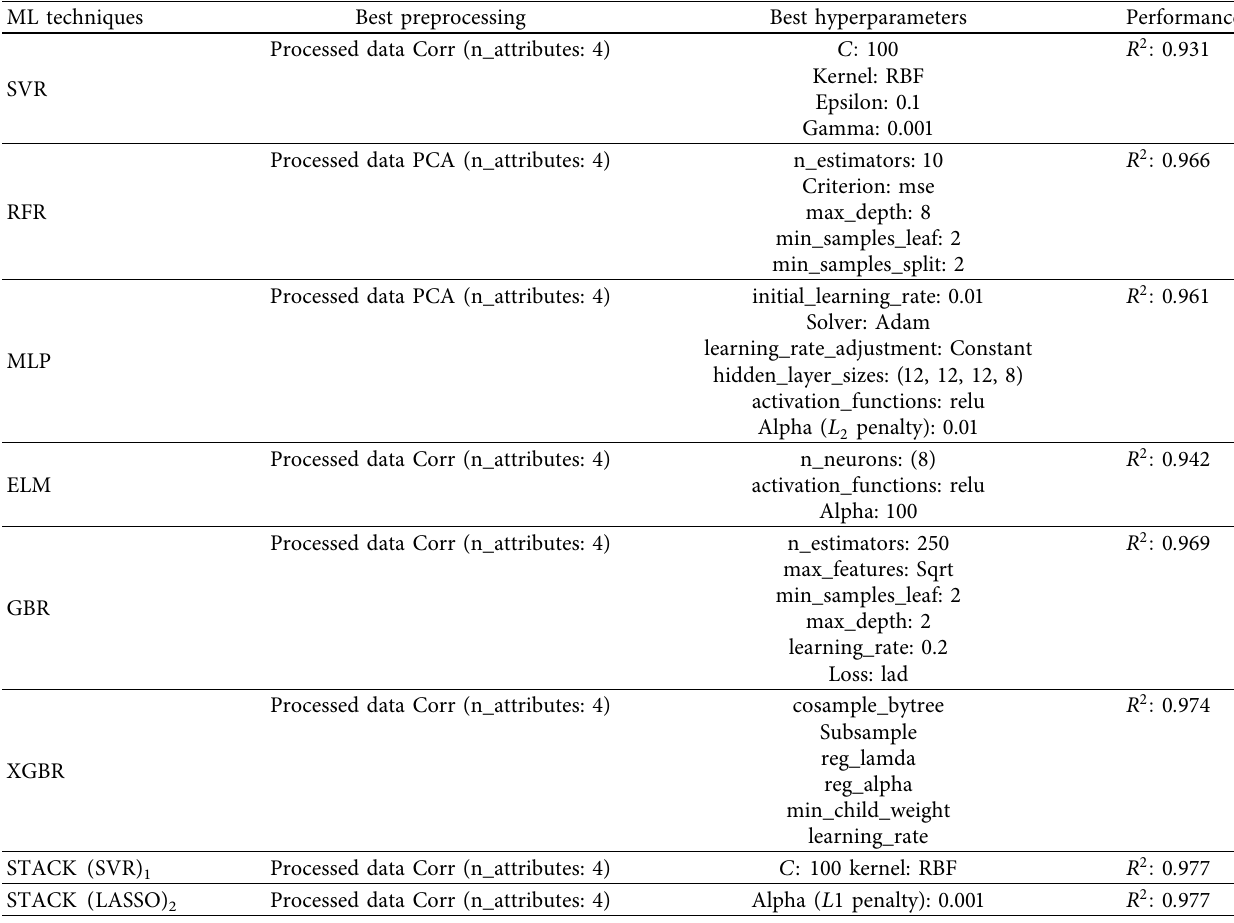
Table 5: Best − -performing ML model and preprocessing and tuned hyperparameters with the highest possible accuracy ( R 2 ) . ML techniques